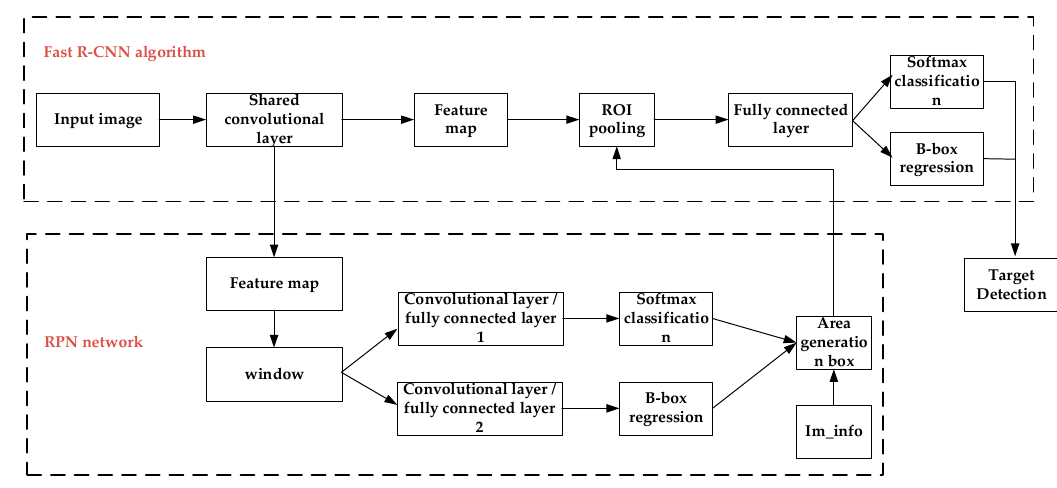
Figure 1. Faster Region-based Convolutional Neural Network (R-CNN) algorithm framework.